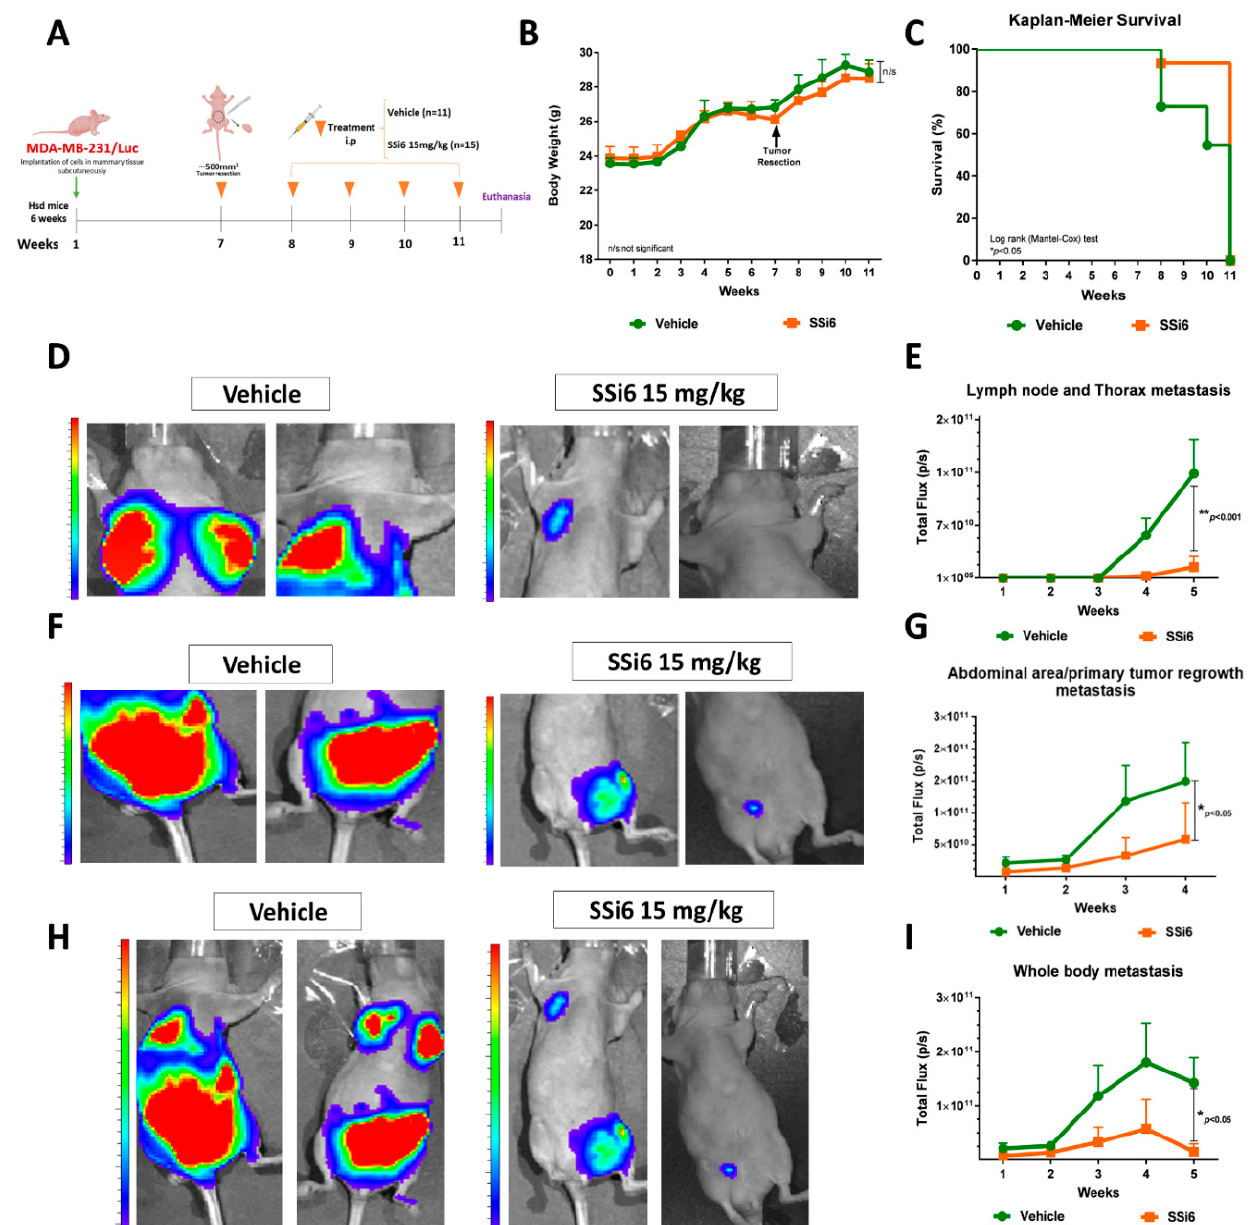
Figure 5. SSi6 increases survival, reduces whole-body metastases and tumor regrowth, after resection of the primary tumor. ( A ) The TNBC MDA-MB-231/Luc tumor was removed with a volume of approximately 500 mm 3 in both groups (vehicle n = 11; SSi6 15 mg/kg n = 15) after treatment was started daily by intraperitoneal route and ended when the mice showed signs of distress. ( B ) Body weight was monitored three times a week, before and after surgical resection of the primary tumors. ( C ) Kaplan–Meier Survival curve from the vehicle and SSi6-treated mice. P -value was calculated by log-rank Mantel-Cox test. ( D ) Representative images of bioluminescence and ( E ) quantification of the upper segment (axillary lymph nodes and thoracic region), ( F ) lower segment, and ( G ) quantification showing the abdominal region and the regrowth of primary tumors, besides ( H ) whole-body images and ( I ) quantification obtained from the sum of each segment of the treated groups (vehicle and SSi6).